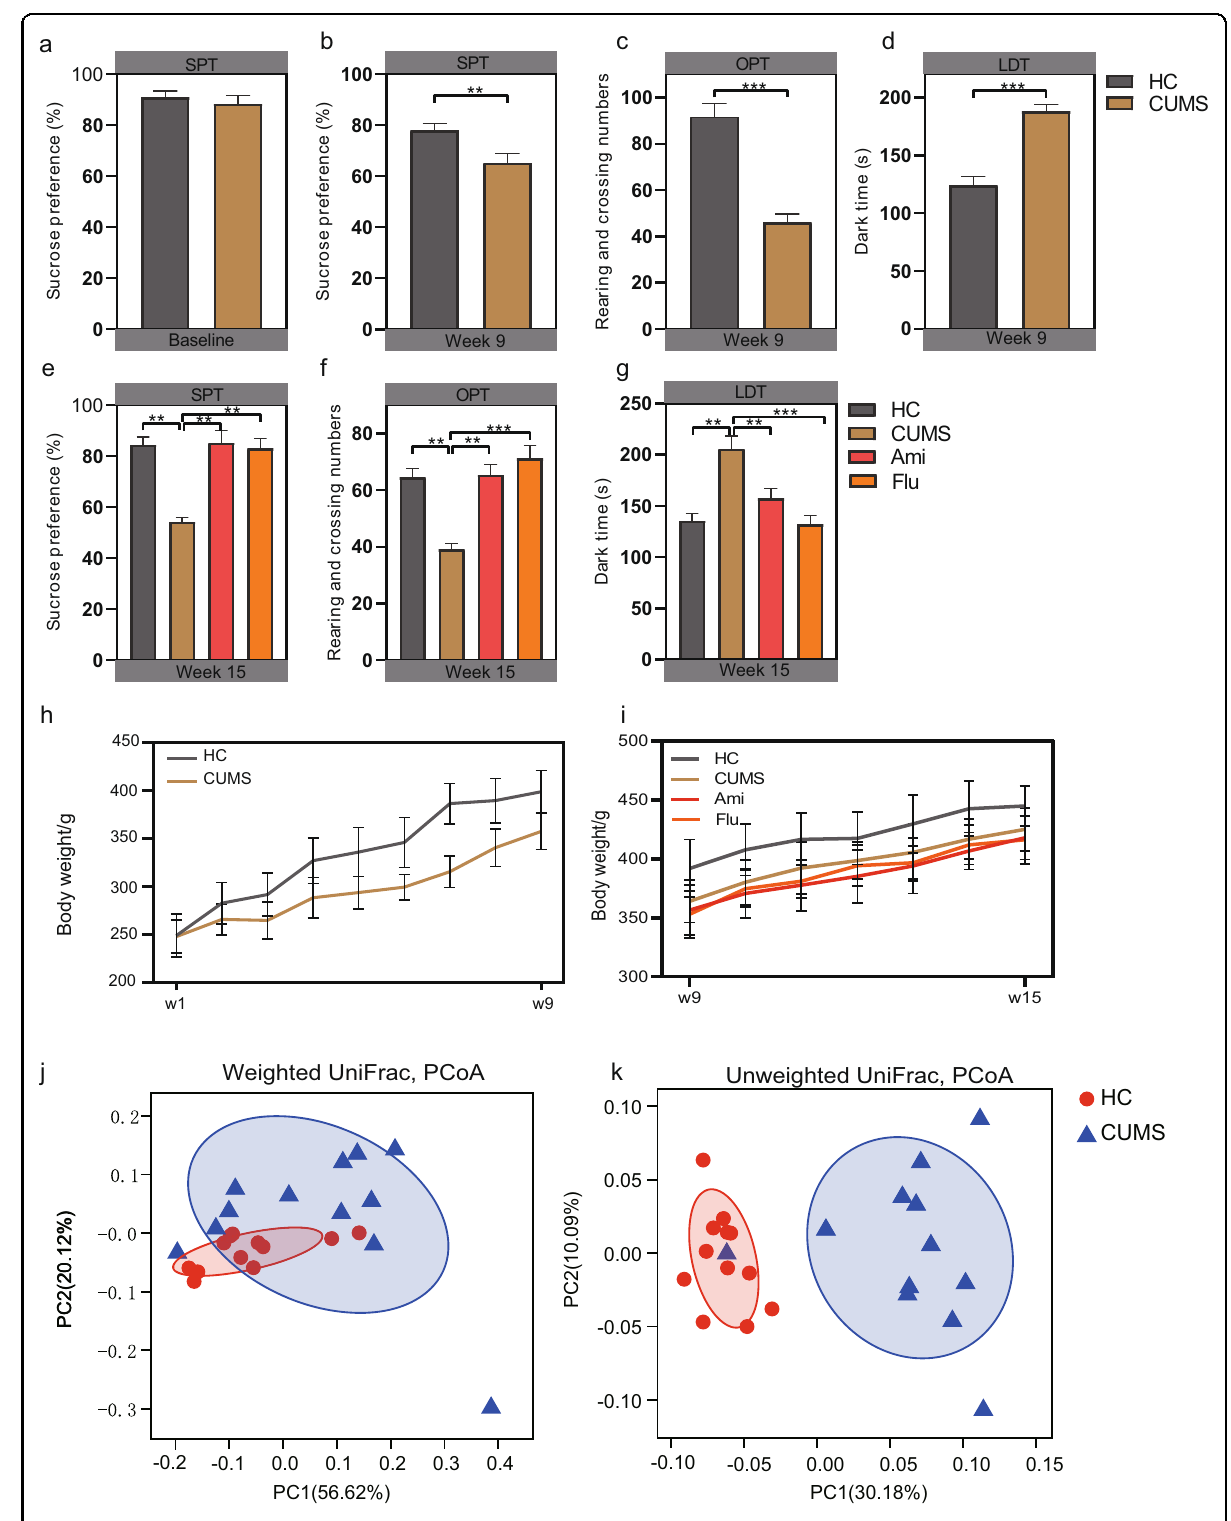
Fig. 1 Depression-like behaviours and PCoA analysis of gut bacterium data at week 9 for evaluation of the CUMS modelling and effectiveness of antidepressant treatment. a Sucrose preference test at baseline. Sucrose preference ( b ), open fi led test ( c ) and light/dark test ( d ) performed after 8-week CUMS exposure. Sucrose preference test ( e ), open fi led test ( f ) and light/dark test ( g ) performed after six-week antidepressants treatment. Changes in body weight from h weeks 1 – 9 and i weeks 9 – 15 in HC and CUMS groups. PCoA of bacterial beta-diversity based on the j weighted and k unweighted UniFrac distances between CUMS rats and healthy controls at week